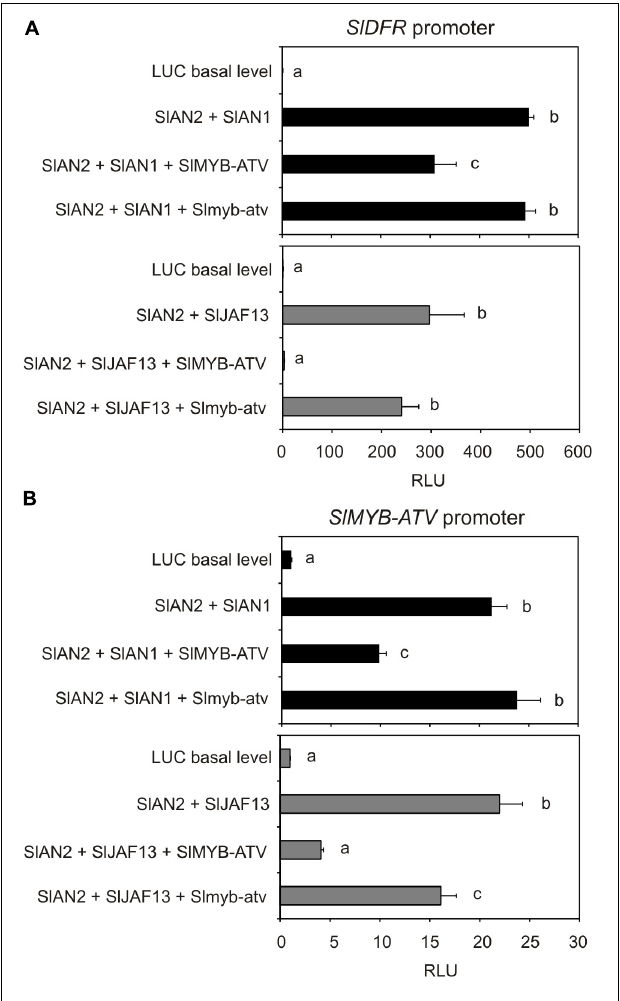
FIGURE 8 | The transient expression of SlMYB-ATV represses both SlDFR and its own promoters. Dual luciferase assays in MicroTom leaf protoplasts transfected with the reporter plasmid containing (A) the SlDFR or (B) the SlMYB-ATV promoter driving firefly luciferase ( FireflyLuc ) gene alone (basal level histogram) or in combination with effector plasmids containing SlAN2 , SlAN1 , SlJAF13 , SlMYB-ATV, and Slmyb-atv sequences, in different combinations. A 35S: Renilla-luciferase ( RenillaLuc ) plasmid was used as an internal control. Data are expressed as Relative Luciferase Activity (RLU) (FireflyLuc/RenillaLuc) and are means of four biological replicates ± SE. One-way ANOVA test (Tukey’s multiple comparisons test, P < 0.05) was carried out. Different letters indicate significant differences in each bar chart plot. Each experiment was repeated at least three times with similar results.